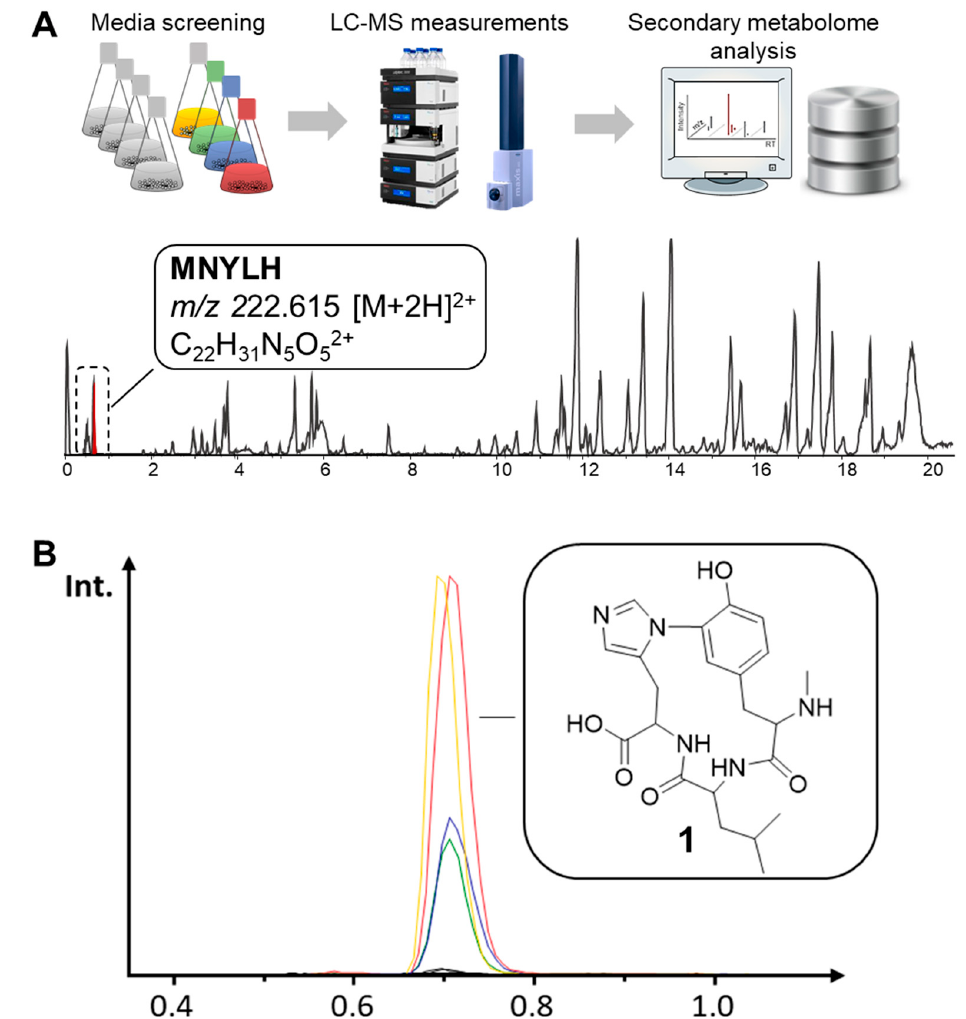
Figure 3. ( A ) Secondary metabolome analyses via HPLC-MS of P. fallax An d48 revealed the target natural product at m/z 222.615 [M + 2H] 2+ , supporting the deduced molecular formula C 22 H 31 N 5 O 5 2+ at a retention time of 0.7 min. ( B ) Production of 1 in different media as observed as an LC-MS EIC at 222.615 ± 0.05 Da [M + 2H] 2+ . The black traces represent media without significant production of 1 , namely AMB, YM, CFL, CTT, M and P media. The blue trace represents P medium containing autoclaved Escherichia coli (Pec), the yellow trace represents P medium containing autoclaved Sac- charomyces cerevisiae (Py), the green trace represents low-concentration-starch-based medium con- taining autoclaved S. cerevisiae (VY/2) and red trace represents high-concentration-starch-based me- dium containing autoclaved S. cerevisiae (VY).